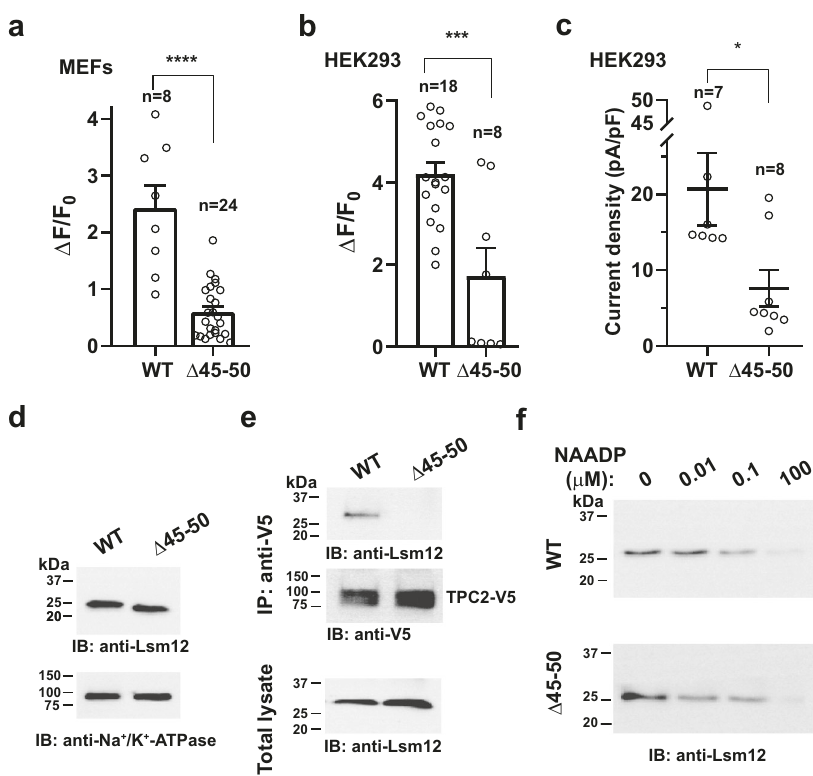
Fig. 7 Lsm12 function in NAADP signaling is compromised by Δ 45 – 50 mutation in MEFs and HEK293 cells. a Averaged NAADP-induced changes in Ca 2 + indicator fl uorescence in MEFs prepared from WT and Lsm12 Δ 45-50 mutant mice. b Averaged NAADP-induced changes in Ca 2 + indicator fl uorescence in HEK293 Lsm12-KO cells transiently expressing TPC2 and Lsm12 WT or Δ 45 – 50 mutant. c Averaged current density of NAADP (100 nM in pipette solution) microinjection-induced whole-cell currents in HEK293 Lsm12-KO cells transiently expressing TPC2 PM and Lsm12 WT or Δ 45 – 50 mutant. d Immunoblot of Lsm12 in MEFs prepared from WT and Lsm12 Δ 45 – 50 mutant mice. MEFs were prepared and pooled from fi ve WT and six Lsm12 Δ 45 – 50 mutant mice, respectively. e Co-immunoprecipitation (IP) of TPC2 (V5-tagged) and LSM12 WT or Δ 45 – 50 mutant transiently expressed in HEK293 LSM12-KO cells. f Immunoblot of Lsm12 WT and Δ 45 – 50 mutant that was transiently expressed in HEK293 Lsm12-KO cells and pulled down by immobilized NAADP in the presence of different concentrations of free NAADP. Data were presented as mean value ± SEM. Unpaired Student ’ s t -test (two-tailed) was used to calculate p values. * , ***, and ***** are for p values ≤ 0.05, 0.001, and 0.00001, respectively. IB immunoblot, IP